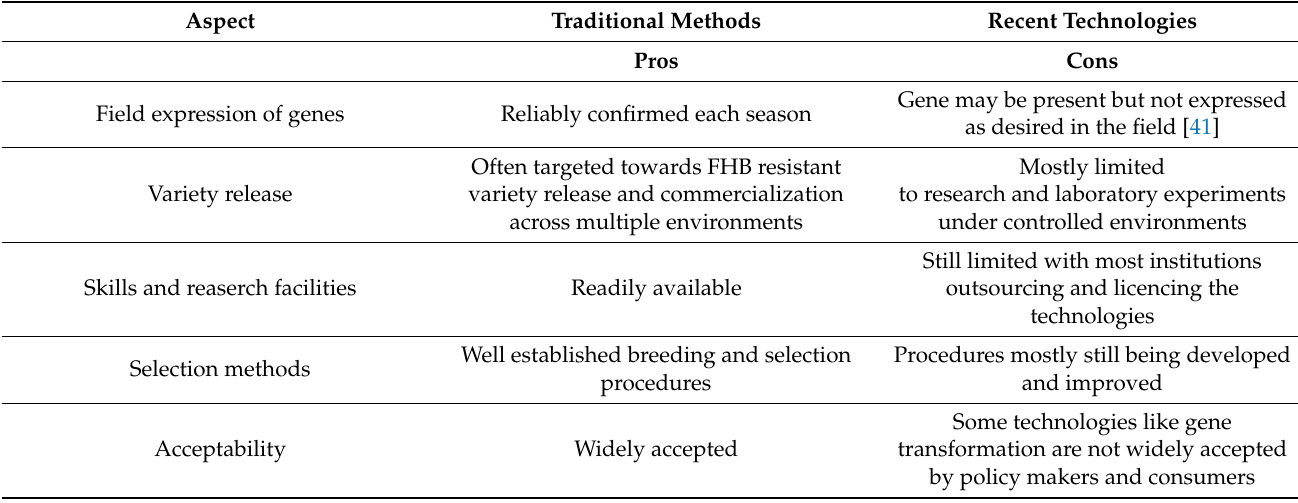
Table 2. Pros and cons of using traditional breeding methods against using recent